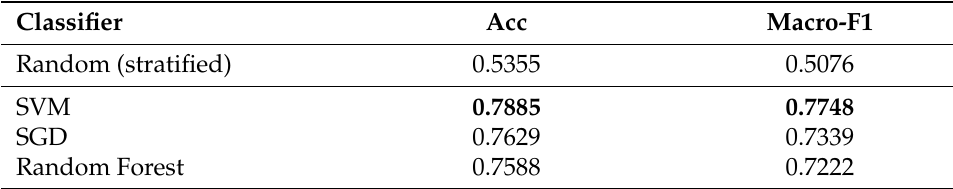
Table 9. Results obtained using the base techniques for competence prediction.